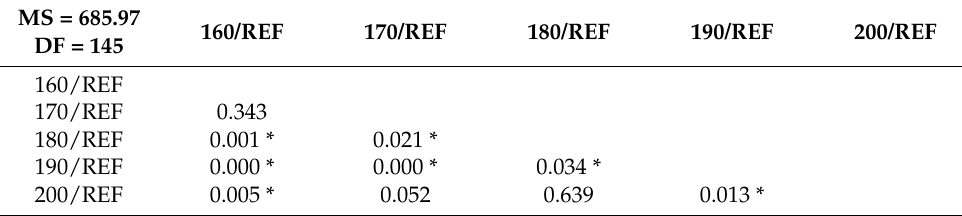
Table A12. Duncan ´ s multiple range test for changes in degree of gloss at 60 ◦ .